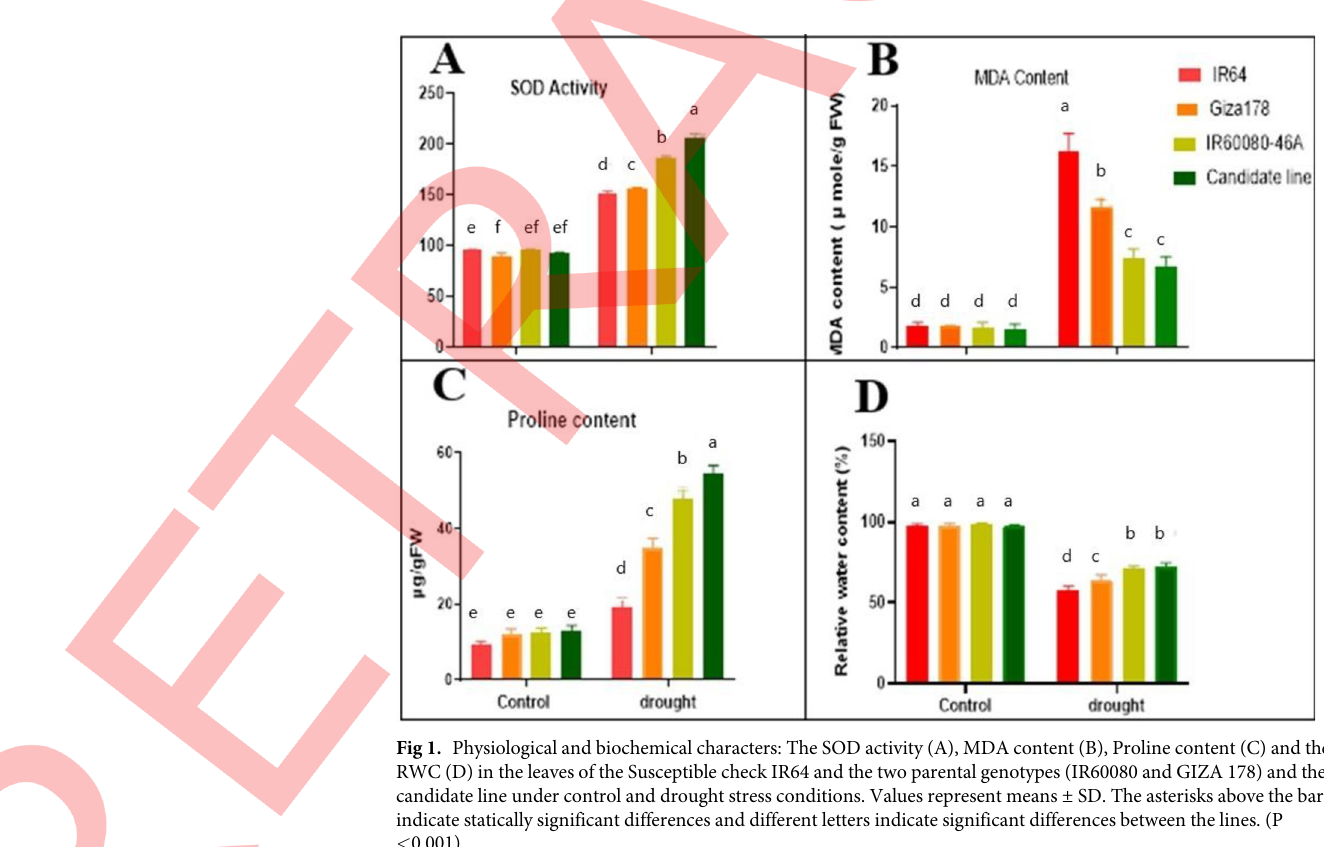
Fig 1. Physiological and biochemical characters: The SOD activity (A), MDA content (B), Proline content (C) and the RWC (D) in the leaves of the Susceptible check IR64 and the two parental genotypes (IR60080 and GIZA 178) and the candidate line under control and drought stress conditions. Values represent means ± SD. The asterisks above the bars indicate statically significant differences and different letters indicate significant differences between the lines. (P <